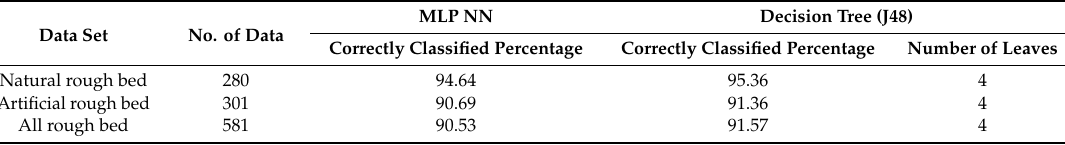
Table 4. Classification accuracy by the decision tree (J48) and NN classifiers for di ff erent